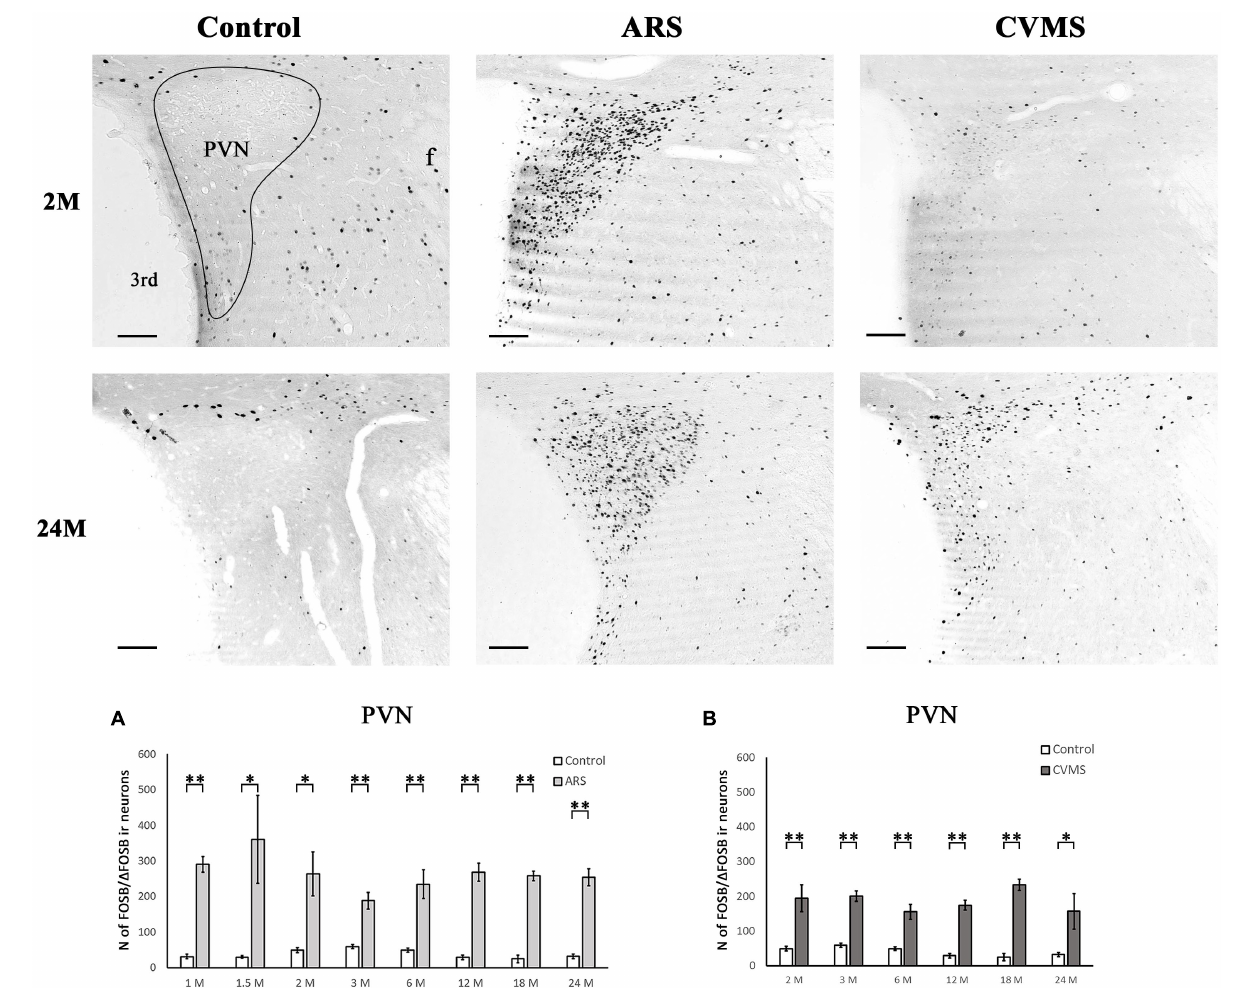
FIGURE 6 | Age-dependent FOSB/ (cid:49) FOSB immunoreactivity (IR) in the paraventricular nucleus of the hypothalamus (PVN). Representative images of 2 and 24-month-old (M) control, acute restraint stress (ARS), and chronic variable mild stress (CVMS)-exposed rats at –1.72 mm to the Bregma. The number of FOSB/ (cid:49) FOSB IR nuclei was compared among eight age groups in histogram (A) for ARS vs. controls and (B) for CVMS vs. controls in the PVN. The ARS resulted in a significantly elevated FOSB/ (cid:49) FOSB in all age groups. The CVMS exposure resulted in FOSB/ (cid:49) FOSB increase in all age groups also. Open bars represent the control groups; light gray columns refer to ARS-exposed rats and the dark gray columns depict CVMS-exposed rats ( N = 4–7). ∗ p < 0.05, ∗∗ p < 0.01 according to t -tests. 3rd, third ventricle; f, fornix. Scale bar: 100 µ